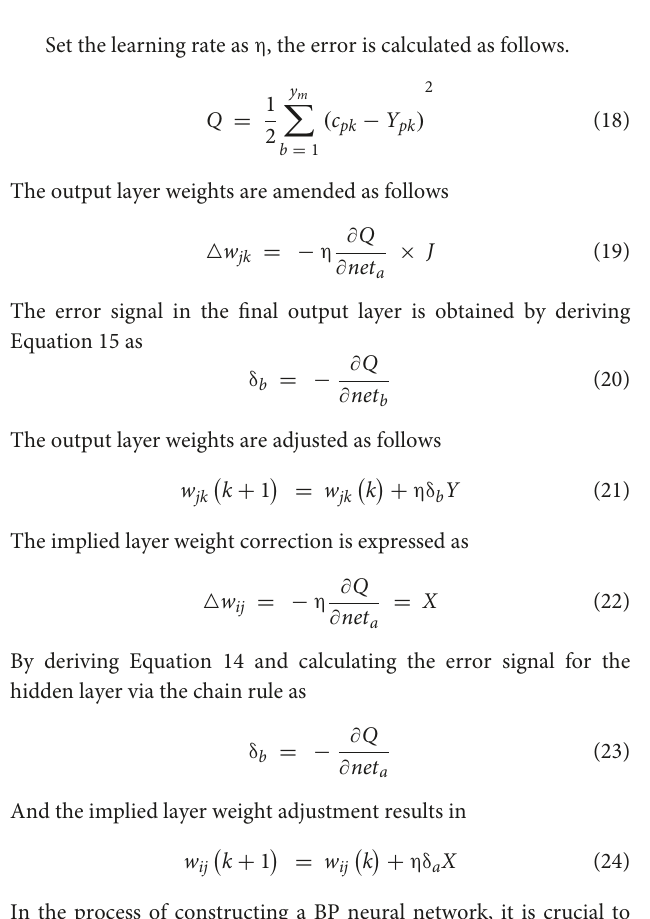
FIGURE1 BP neural network